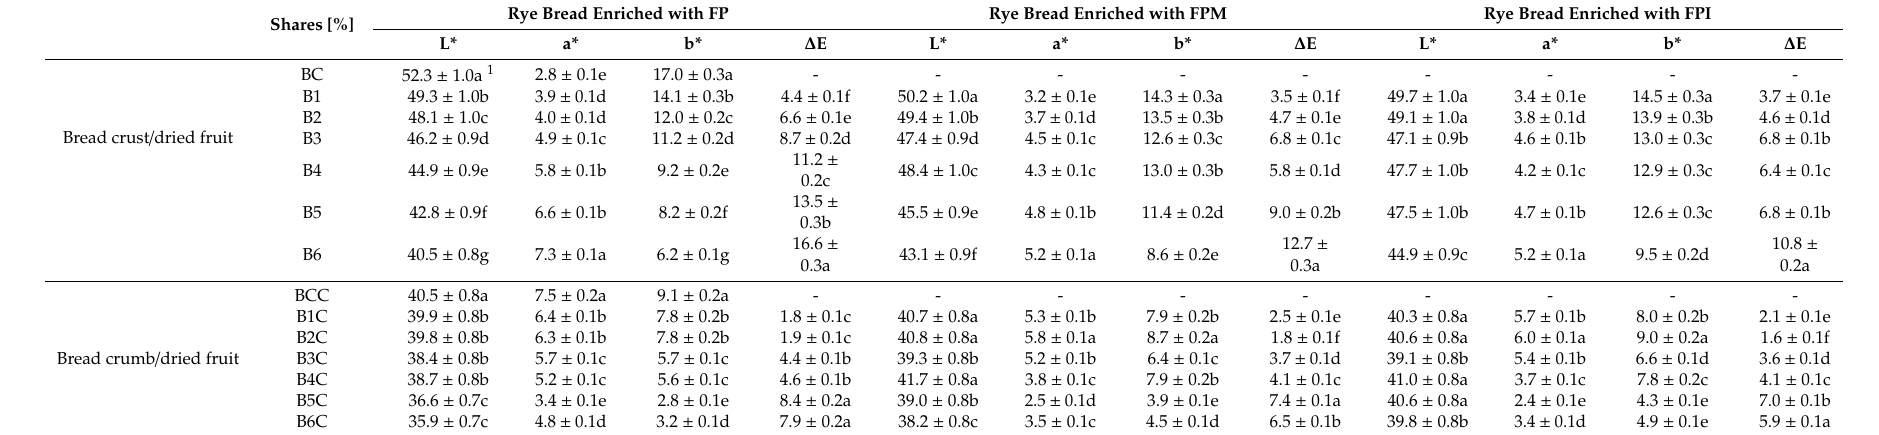
Table 1. The colour parameter of enriched rye bread. FP, pure fruit powder; FPM, encapsulated fruit powders with maltodextrin; FPI, encapsulated fruit powders with